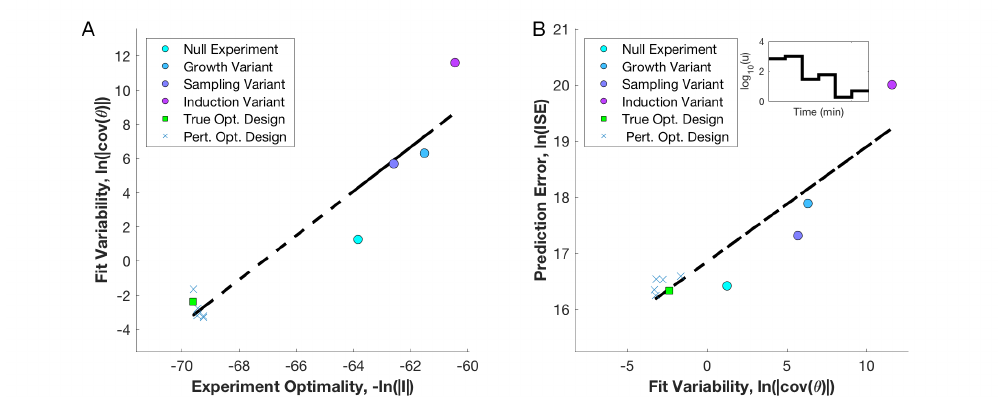
Figure 4. ( A ) Results from the true optimal (optimal experiment designed at true parameter value) and null experiments (circles): optimality score on the horizontal axis; observed generalized variance of the parameter estimate on the horizontal axis. ( B ) The same experiments: generalized parameter variance on the horizontal axis; log integral of the squared error on an out-of-sample prediction experiment (inset) on the vertical axis. Optimal experiments designed with erroneous initial parameter guesses are shown as X’s. (Linear trend lines also